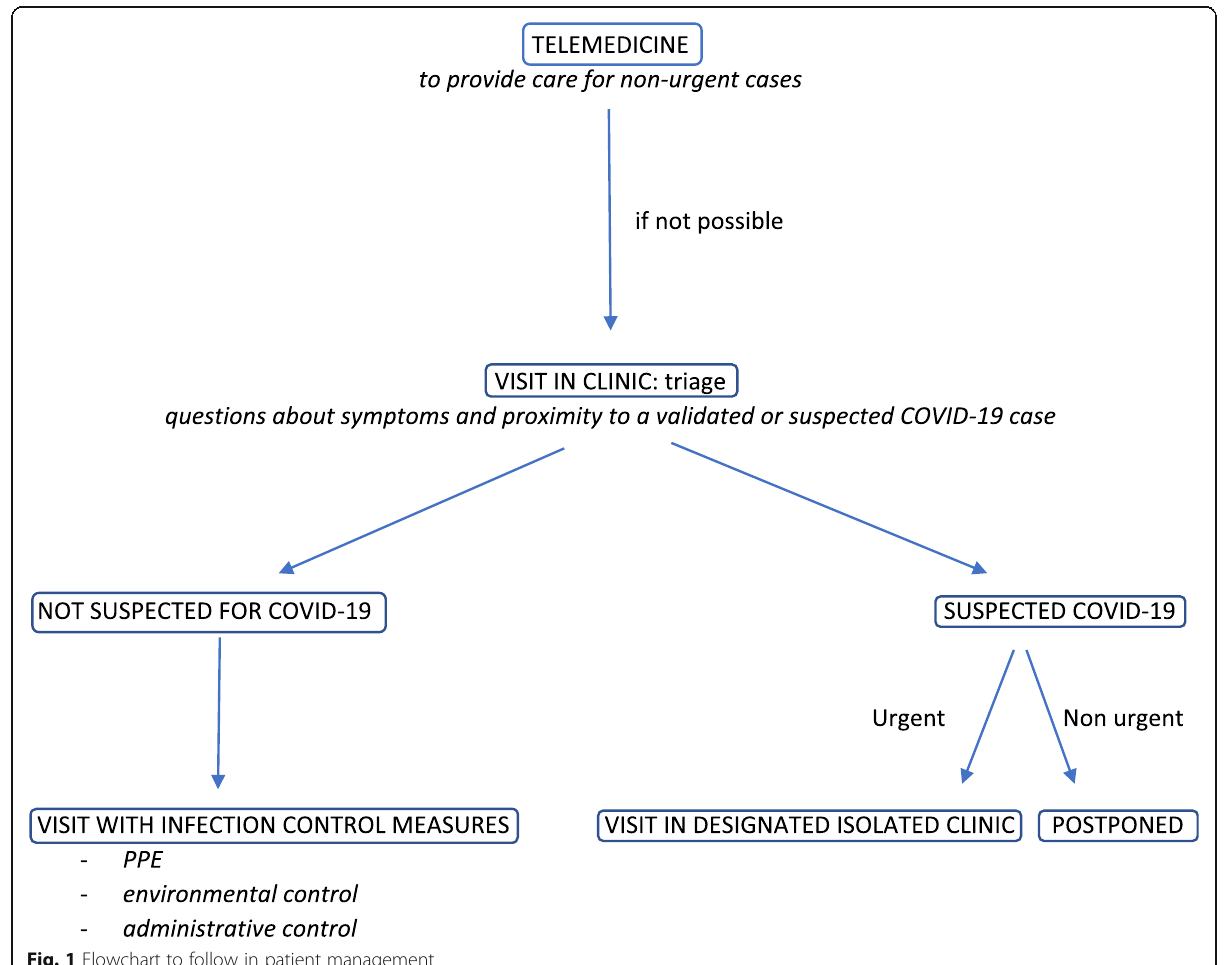
Fig. 1 Flowchart to follow in patient